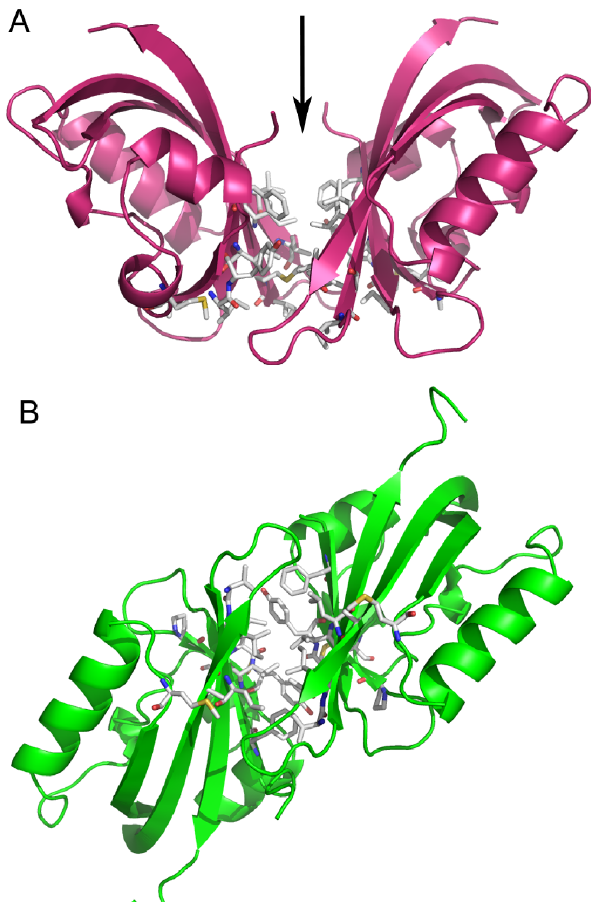
Figure 5. Crystal contacts formed by hydrophobic patch. a) Lattice packing of two molecules of hERG PAS domain. The molecules are related by 2 fold crystallographic axis indicated by arrow. b) Packing of two molecules in the asymmetric unit of the mEAG PAS domain. The two molecules have a , 2-fold relation that is roughly perpendicular to page. In both panels the two molecules on the right are shown in a similar orientation. Residues from the hydrophobic patches are shown as stick.